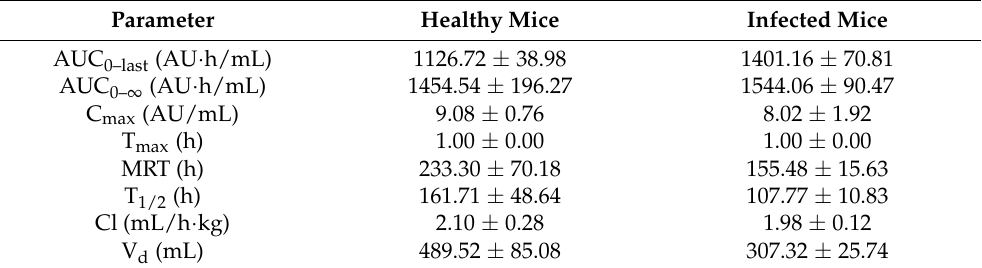
Figure 2. Pharmacokinetic profile of COVID-HIGIV in healthy and SARS-CoV-2 infected mice. Healthy C57bl/6 mice (red) were administered 400 mg/kg (3052 AU/kg) COVID-HIGIV i.v. and sam- ples collected by serial sacrifice from 1 to 360 h after administration. Transgenic K18hACE2 transgenic mice (black) were identically treated but were infected with 4.7 × 10 3 TCID 50 SARS-CoV-2 (strain US_WA1/2020) i.n. immediately after COVID-HIGIV administration. Each data point represents the mean ± SEM of five or six individual animals. Table 1. Calculated mean ± standard error of the mean for pharmacokinetic parameters of COVID ‐ HIGIV in healthy C57bl/6 mice and SARS ‐ CoV ‐ 2 infected K18hACE2 transgenic mice.